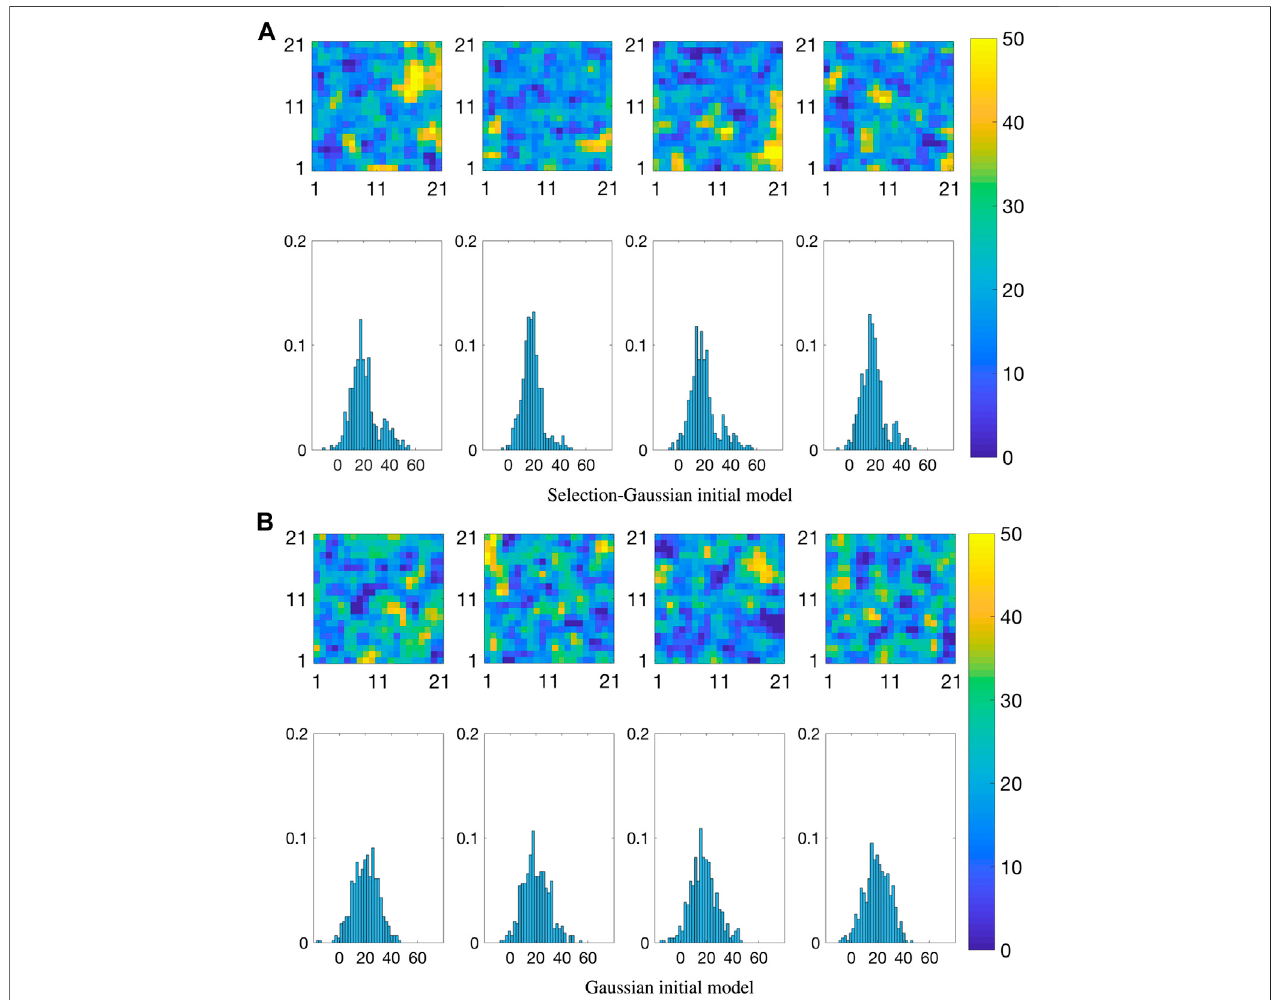
FIGURE 7 | Realizations from the prior distribution of the initial state; maps (upper) , spatial histograms (lower) .